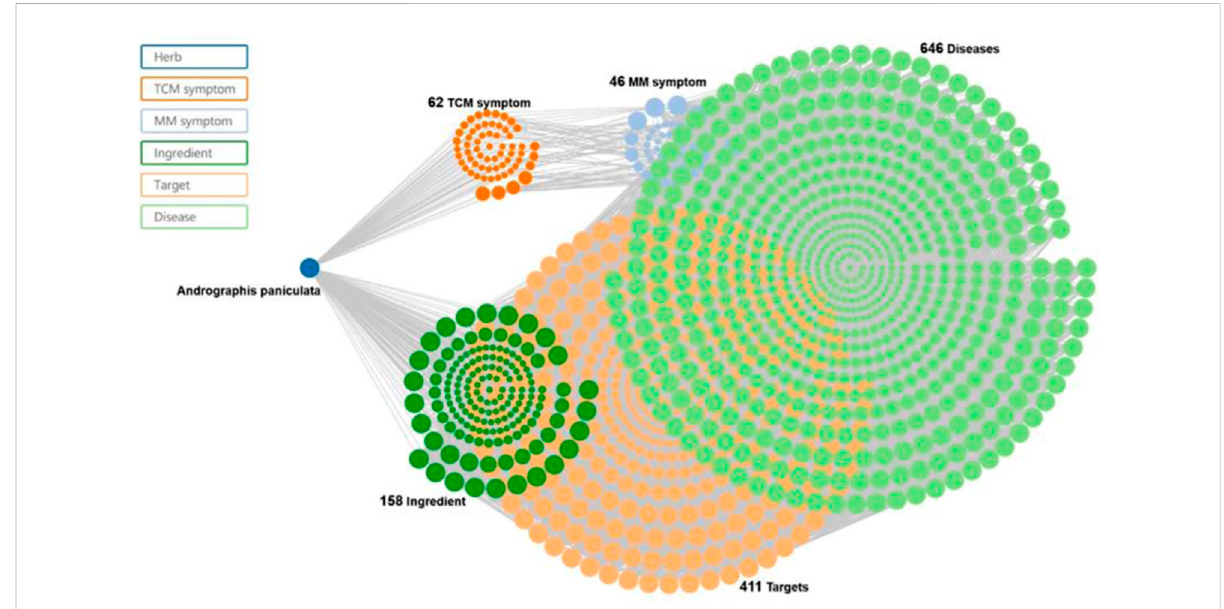
FIGURE 1 TraditionalChinesemedicine(TCM)symptom-Chinesemedicine-targetnetworkoftheChinesemedicine.AndrographispaniculataandChuan